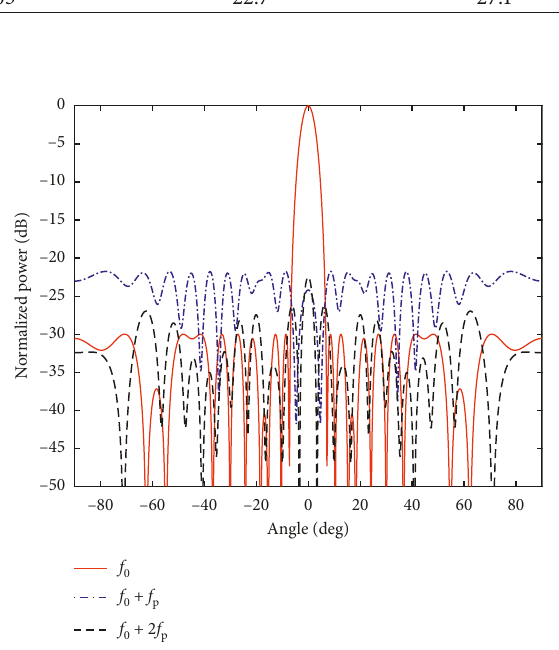
Figure 17: 16-element equal-amplitude in-phase excitation in the PS